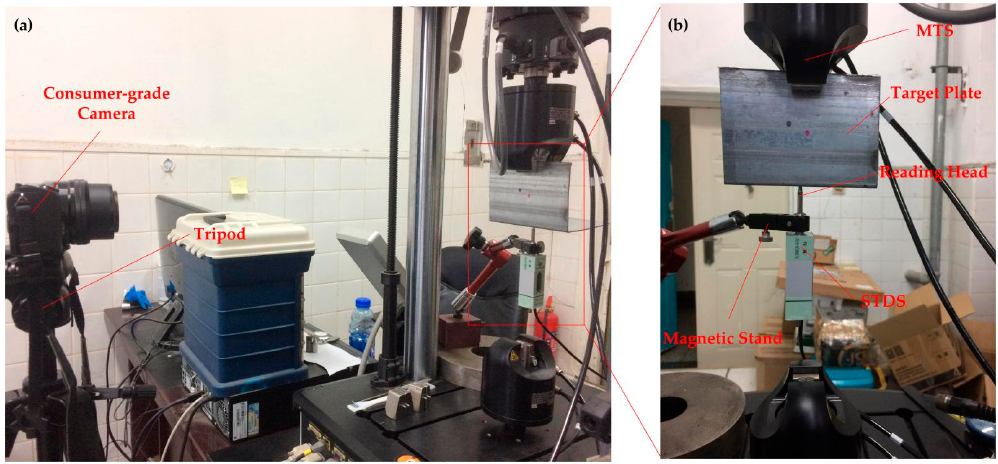
Figure 9. Setup for moving platform experiment: ( a ) Experimental setup; ( b ) Setup of target plant region.